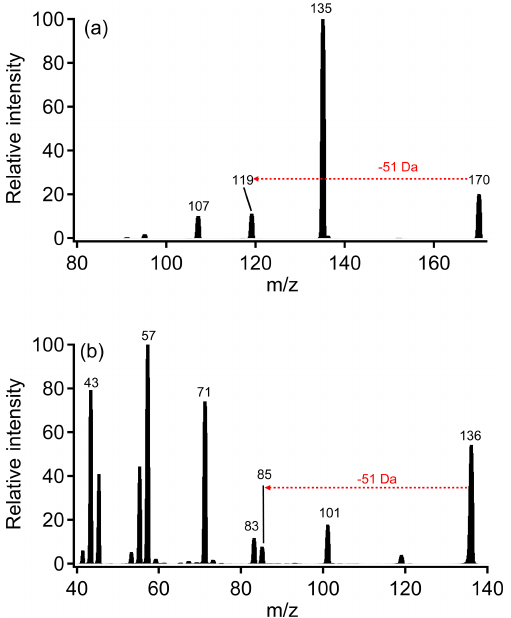
Figure 1. ( + )-APCI mass spectra of ROOH with and without addition of ammonium acetate (AA) for (a) cumene HP and (b) ISOPOOH.